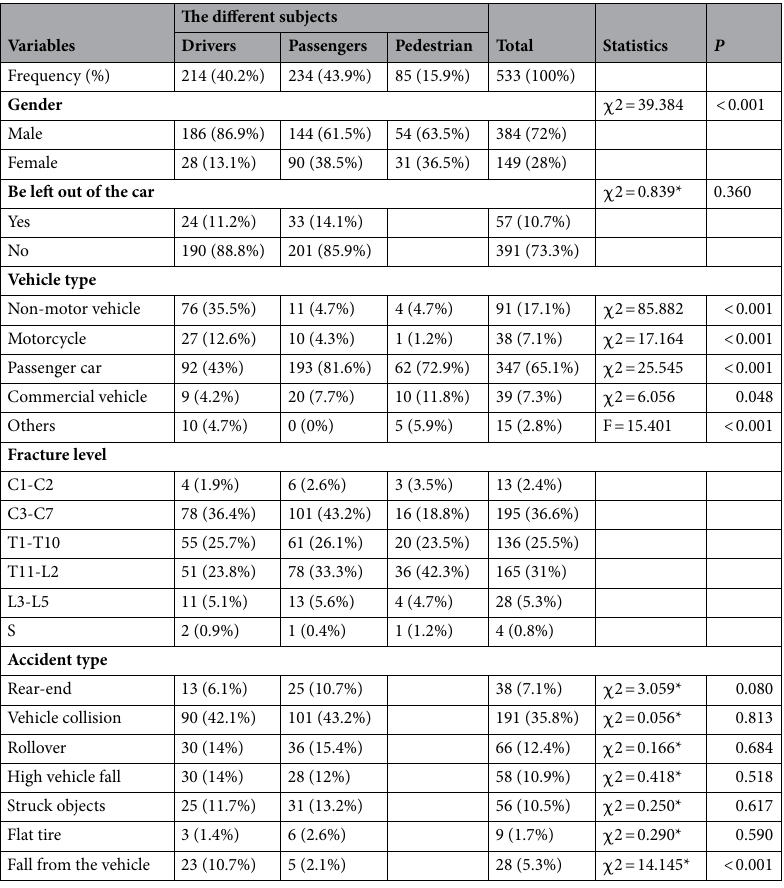
Table 3. Characteristics of 533 cases caused by MVCs according to different subjects. *Except for the comparison of this group of data using Chi-square test of 4 lines data, the rest adopt Chi-square test of 2 lines X 3 lists data.